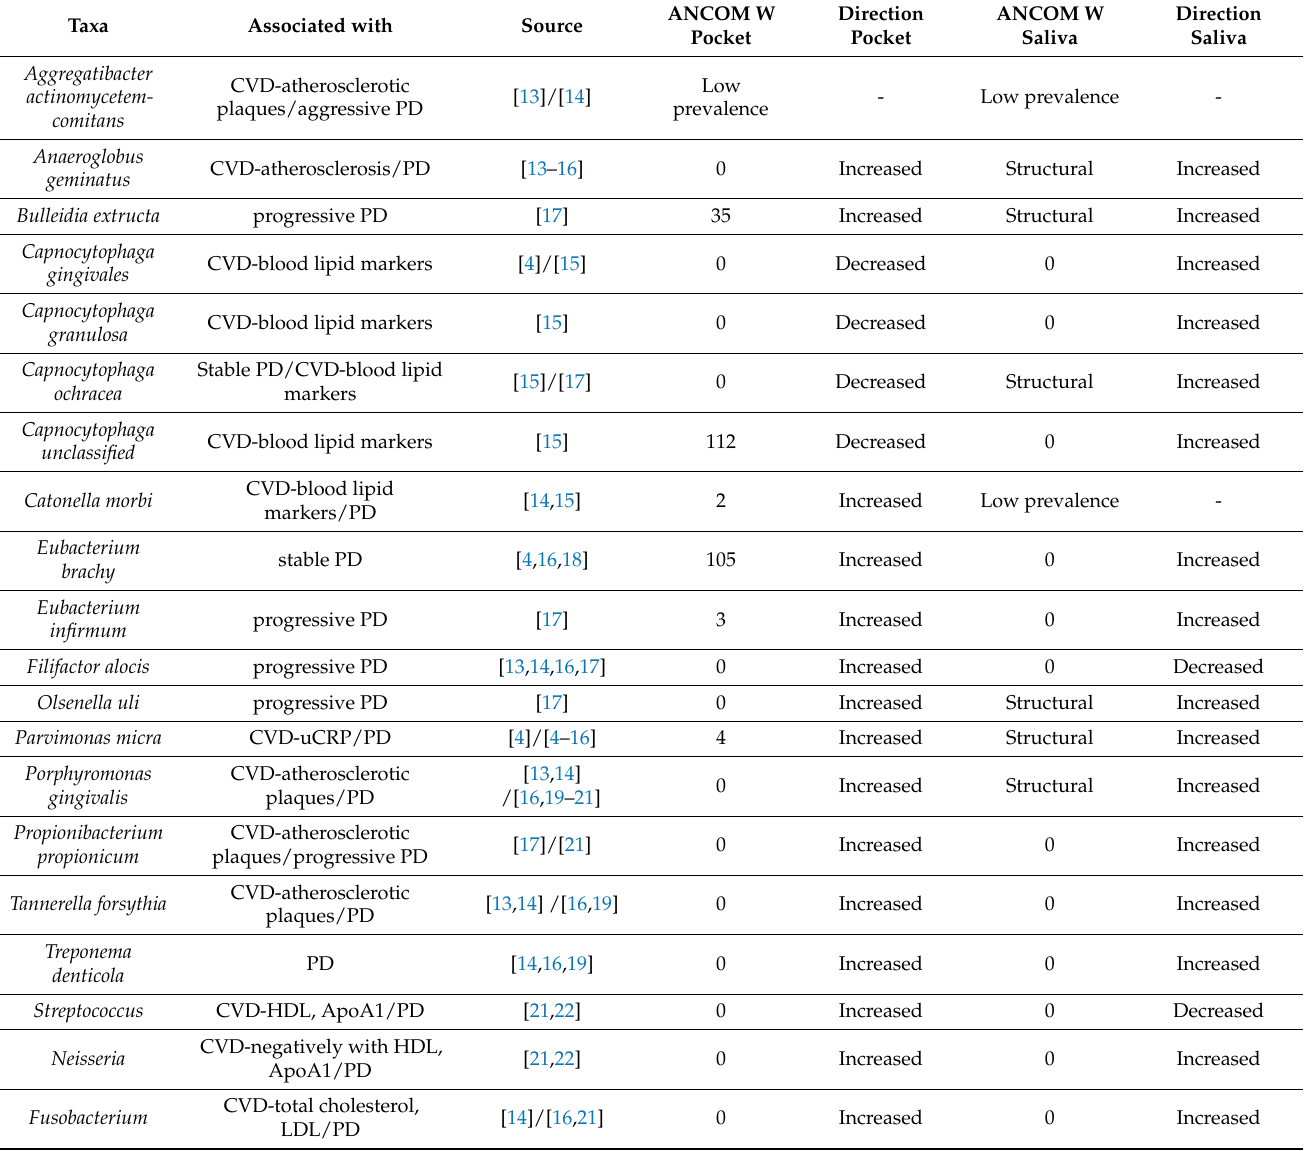
Table 2. Oral bacteria previously reported in the literature to be associated with PD and CVD. W values provided by ANCOM per bacterial community source (pocket/saliva) indicate the number of ratios that pass a significance threshold for each species (see Methods). The direction of the effect size, assessed by a clr-normalized linear model, is indicated, showing whether the species was more or less abundant in severe PD. The species filtered out due to low prevalence in the population are indicated. ‘Structural 0’ indicates the absence of the taxa in one disease group due to putative biological differences between the